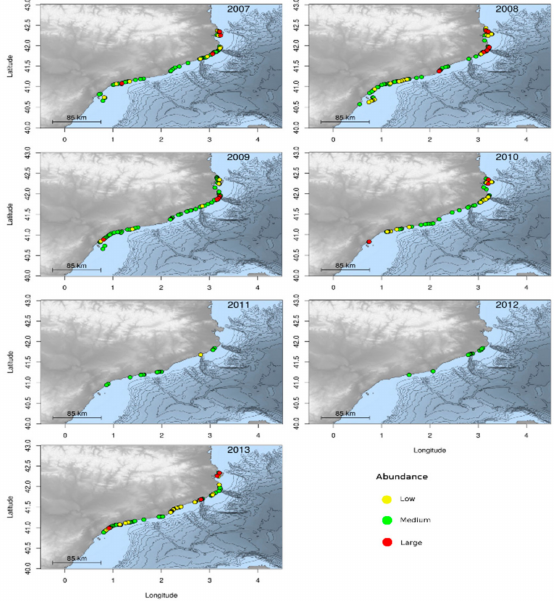
Figure 9. Spatial distribution of jellyfish reports from 2007 (upper-left panel) to 2013 (lower-left panel) for Pelagia noctiluca in Spain. Abundance categories are shown as follows: category 1—“low” in yellow, category 2—“medium” in green, and category 3—“high” in